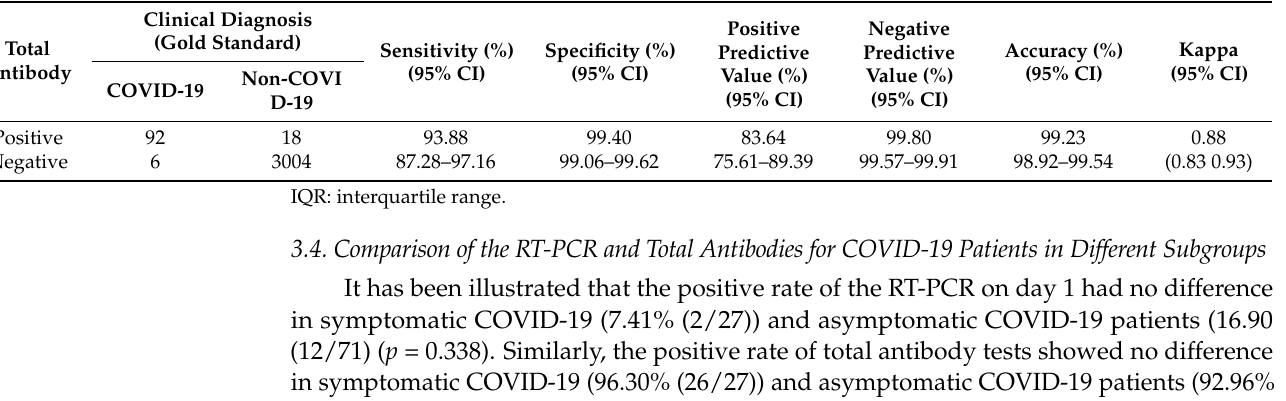
Table 3. The detection of antibodies and RT-PCR tests for COVID-19 patients in different subgroups.